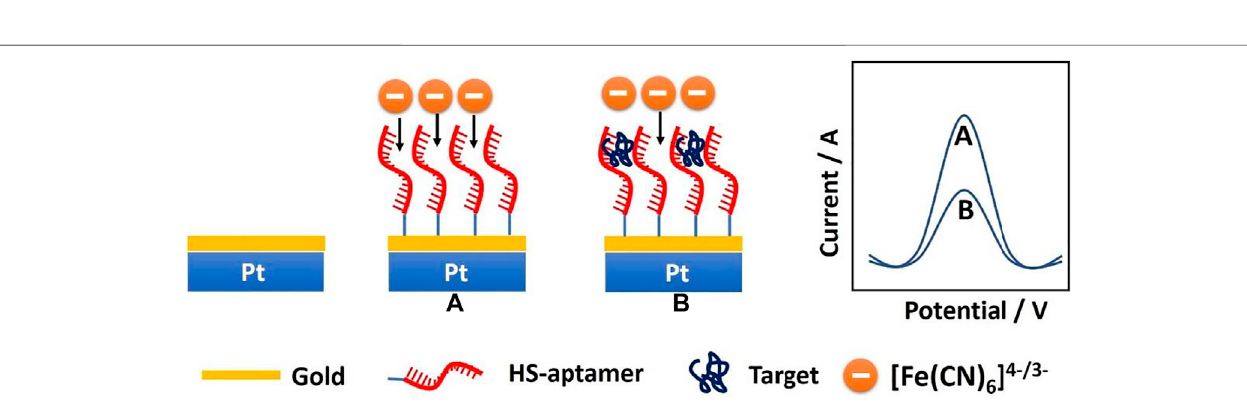
SCHEME 1 | Schematic illustration of the Pt μ Es/Au aptasensor for quantitative analysis of CEA through square wave voltammetry in blood.